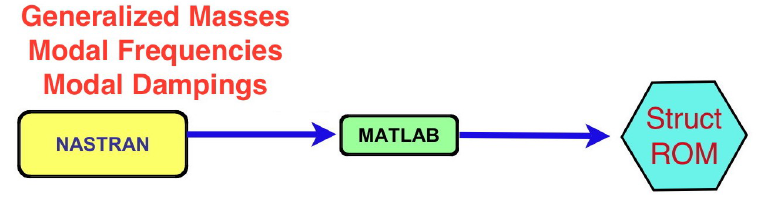
Figure 3. Process for generation of a structural dynamic state-space